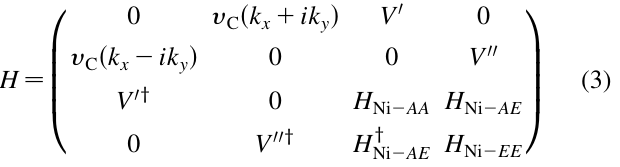
FIG. 6. Diminishing band gap in a simplified model for graphene on Ni(111) or Co(0001). The model in geometry (a) corresponds to Eq. (2) and holds near (cid:1) K . The hopping and on-site energy parameters are assigned typical values: E ¼ 0 , t ¼ 3 eV , t ¼ 2 eV , and t 0 ¼ 0 : 5 eV . In (b) and (c), W is set to 0 and (cid:3) 4 V , respectively, illustrating the emergence of E s V C almost linear dispersion in the case of a large energy difference eW